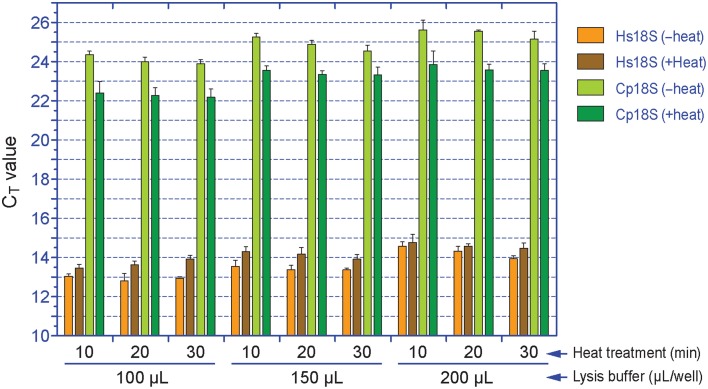
Effects of the amount of lysis buffer and heat treatment on the release of RNA from Cryptosporidium parvum and HCT-8 cells. Cell lysates were first diluted by 100 and 2000 times with nuclease-free water prior to qRT-PCR detection for Cp18S and Hs18S rRNA transcripts, respectively. The plotted CT values were not calibrated to equal volume of lysis buffer. Bars represent standard error of the mean (SEM, n = 6). Heat treatment vs. un-treatment control, p < 0.005 by Student's t-test in all samples.